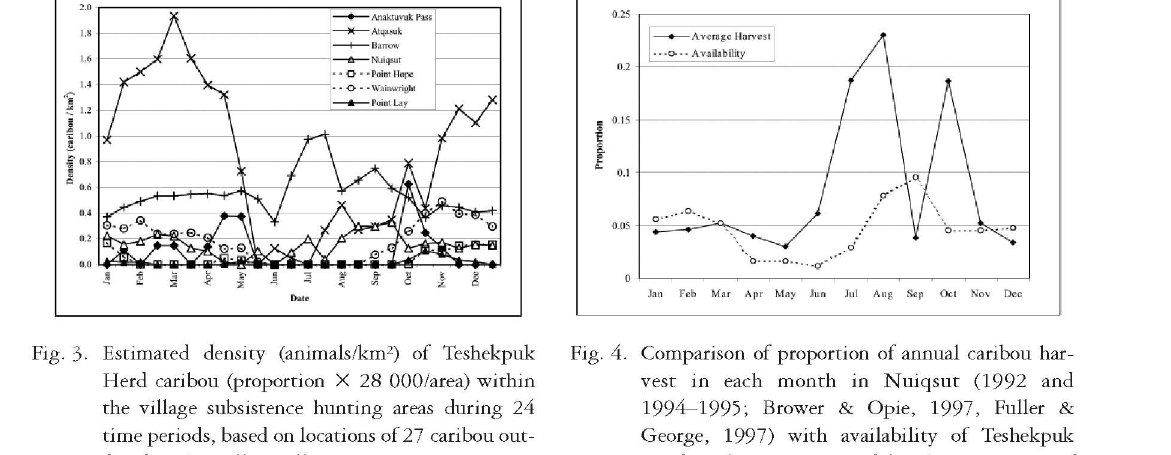
Fig. 3. Estimated density (animals/km 2 ) of Teshekpuk Herd caribou (proportion X 28 000/area) within the village subsistence hunting areas during 24 time periods, based on locations of 27 caribou out¬